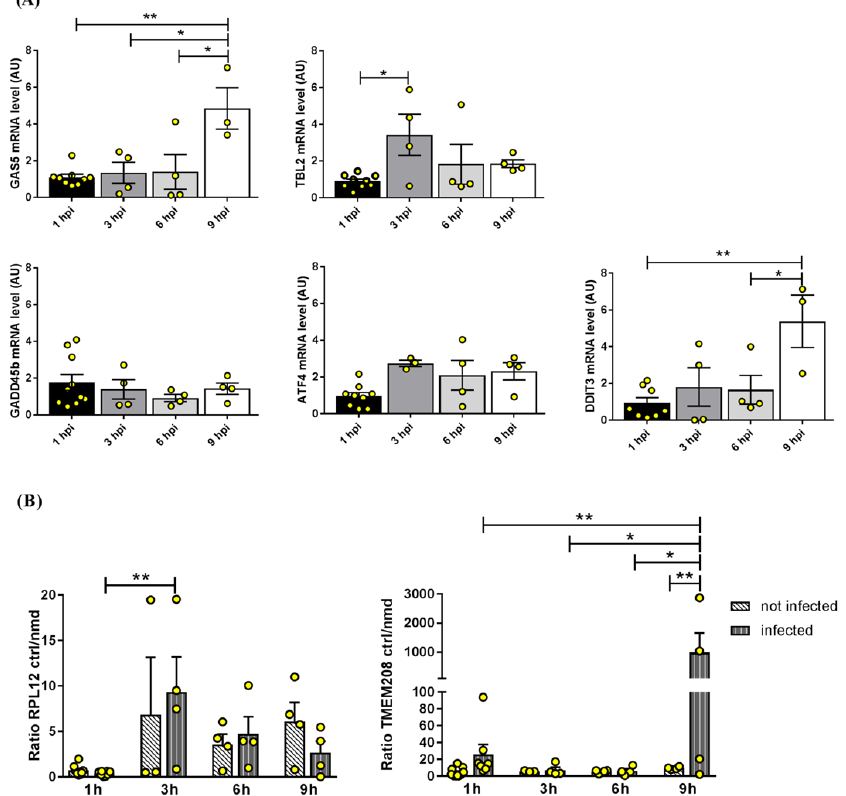
Figure 4. ( A ) Gene expression analysis of known targets of the NMD pathway during a SARS-CoV- 2 infection of Calu3 cells. ( B ) Ratio of the abundance of NMD-non-targeted (control, ctrl) and NMD- targeted transcripts for RPL12 and TMEM208 genes in non-infected and SARS-CoV-2 infected Calu3 cells over time. Each bar represents the mean of at least four technical replicates ± standard error of the mean (SEM); analysis of the outliers was performed using the ROUT method and Q = 1%. * p < 0.05, ** p < 0.01. One-way or two-way ANOVA with the Bonferroni multiple comparison test, re- spectively.